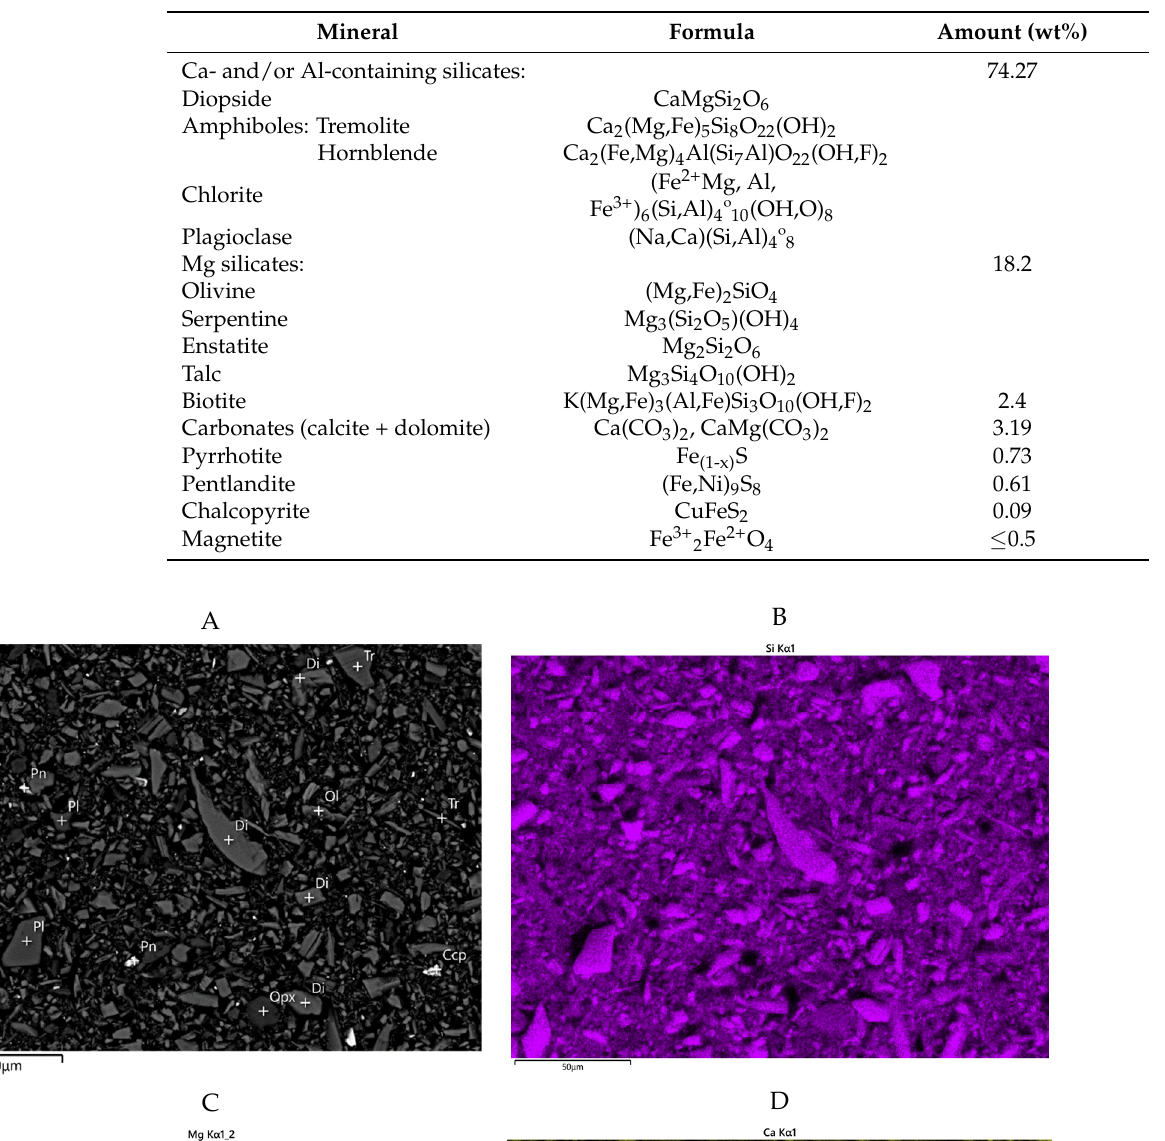
Table 6. Chemical composition of the minerals in the DAF overflow solids.